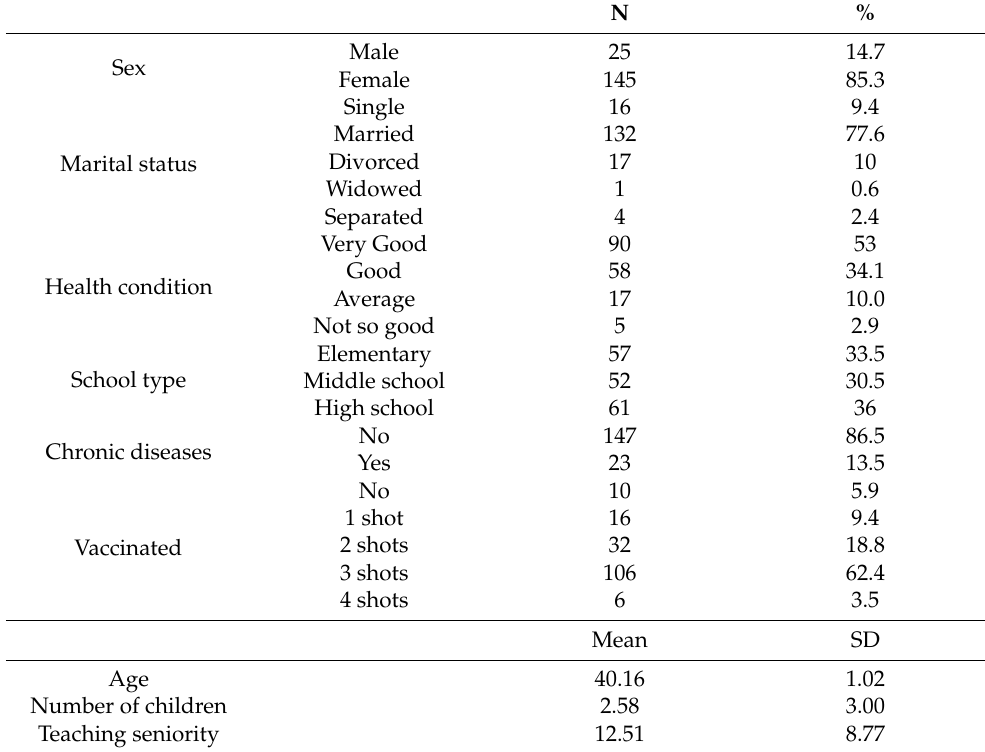
Table 1. Participants in the quantitative study (N = 170).